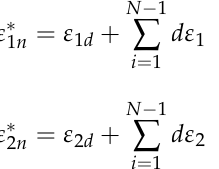
Figure 11 is a FLD based on the C-H instability criterion and the Hill48 yield criterion when considering the induced stress in the thickness direction. Figure 12 is a FLD based on the C-H instability criterion and the Mises yield criterion when considering the induced stress in the thickness direction. Compared with MMFC instability criterion, the overall change trend of FLD based on C-H model is similar. The curve of the tension and com- pressed zone increases as t increases, so the forming limit increases; The curve of the biaxial tension zone decreases as t increases and becomes shorter; However, on the left side, the slope of the FLC which is based on the C-H instability model rises very small, so the curve change is not obvious; while the slope of the curve on the right side is more obvious.